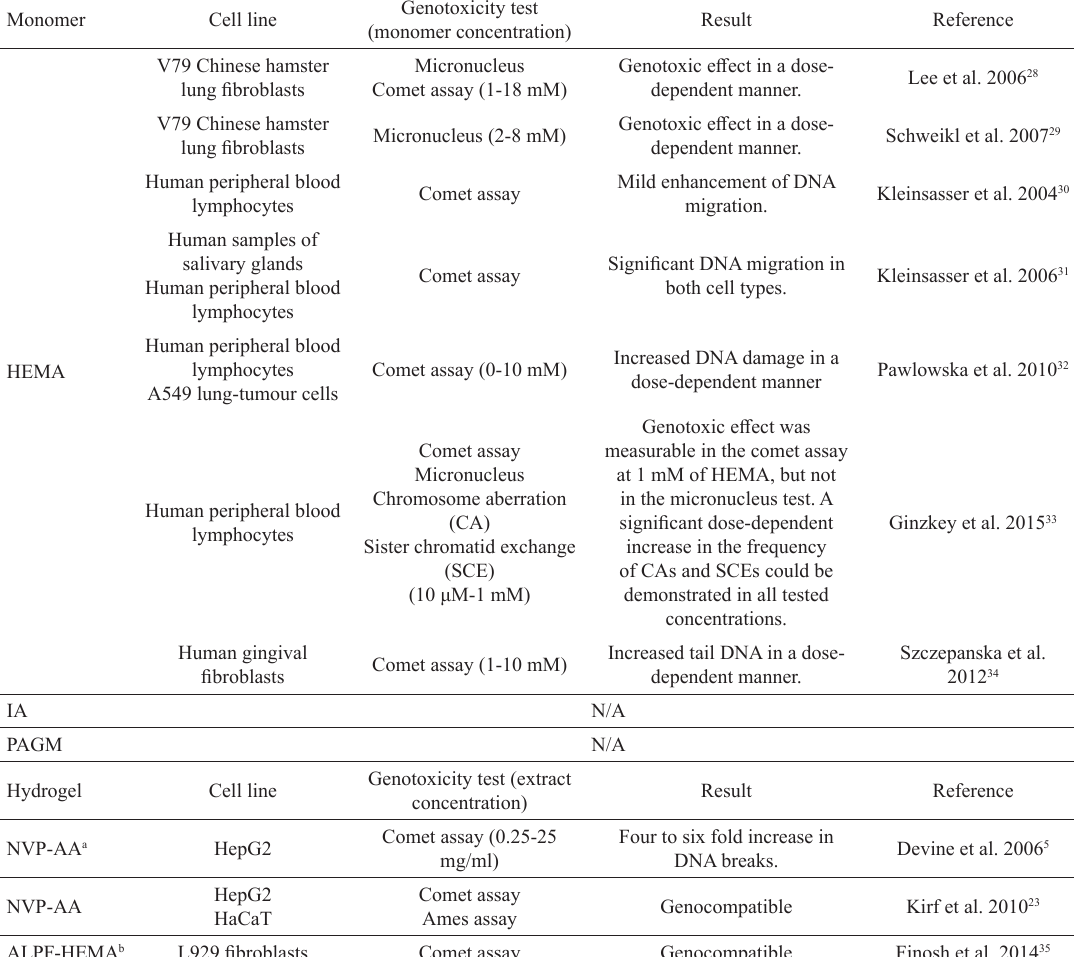
Table 1: Genotoxic potential of HEMA monomer and extracts of polymerized hydrogels assessed in various cell types by employing different genotoxicity tests.